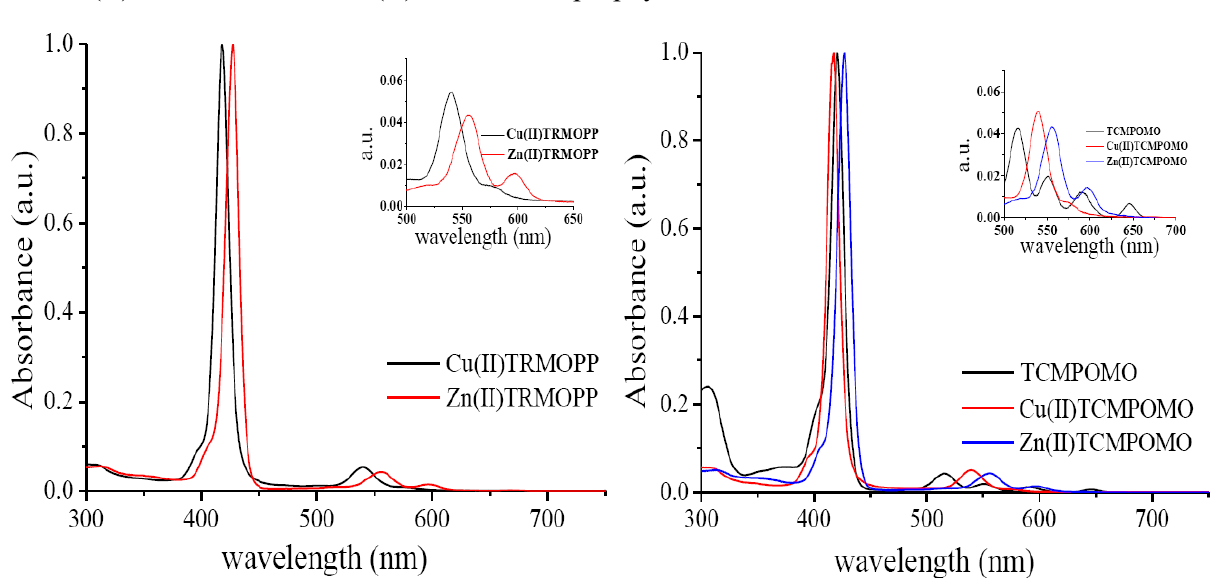
Figure 2. Normalized UV-Vis spectra of Cu(II)TRMOPP, Zn(II)TRMOPP, TCMPOMO, Cu(II)TCMPOMO and Zn(II)TCMPOMO porphyrins in